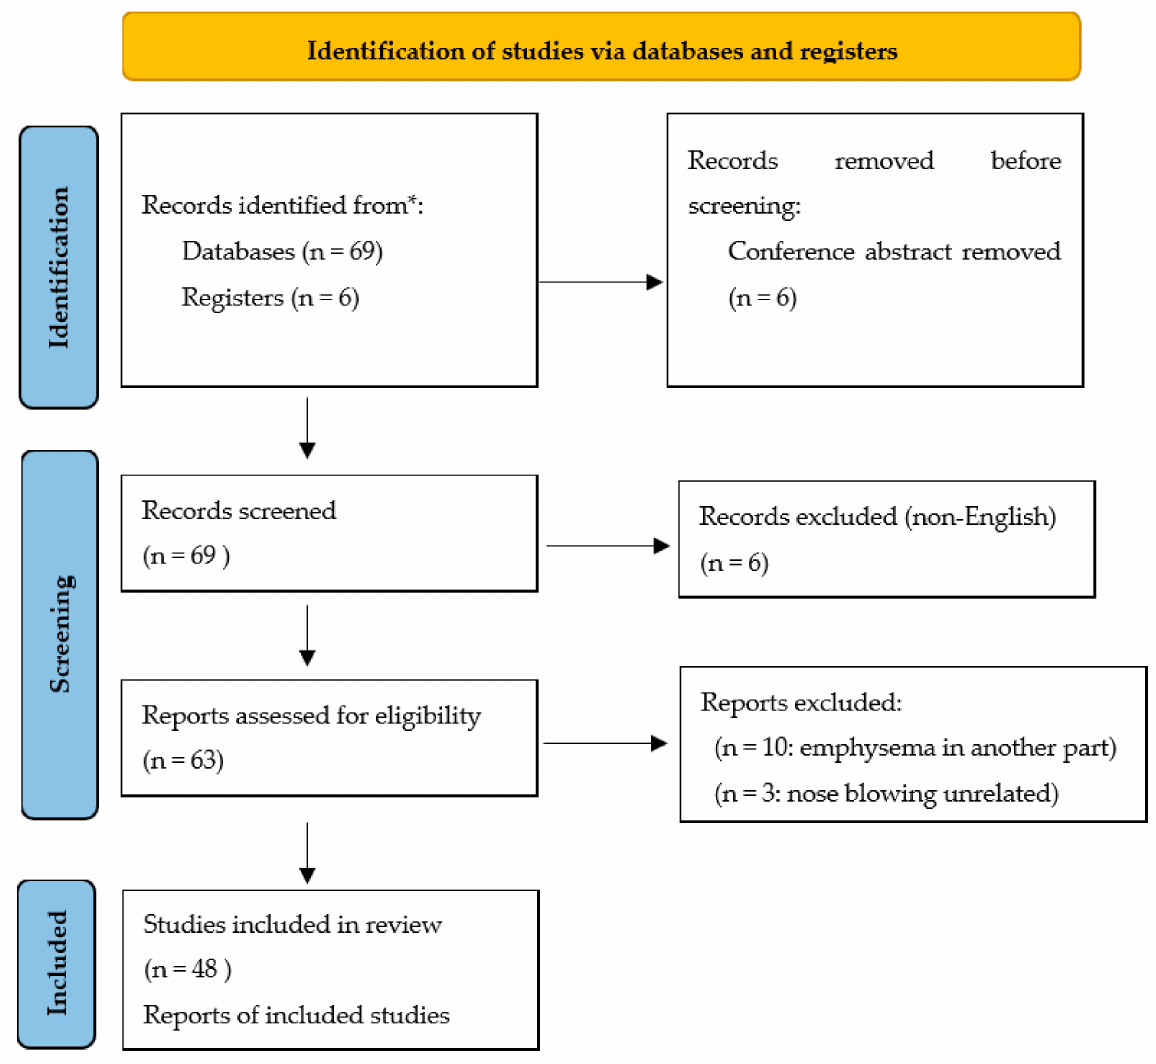
Figure 2. PRISMA flow diagram. *: Pubmed and